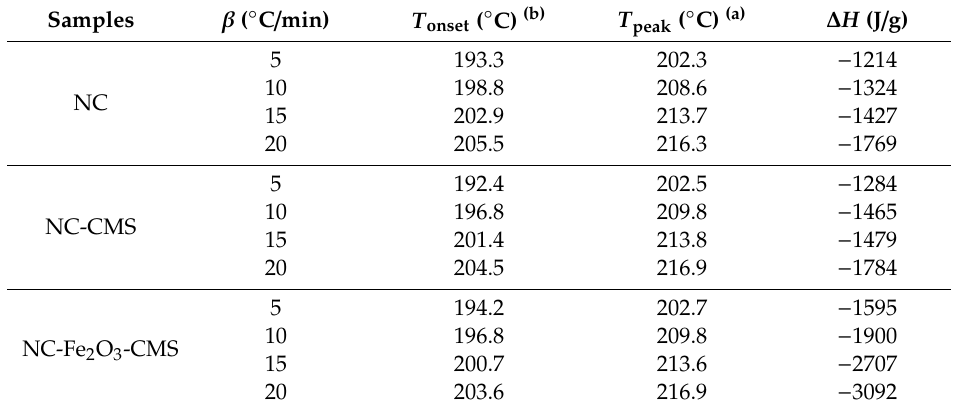
Uncertainty u associated with the top decomposition temperature is u ( T peak ) = ±0.2 K.